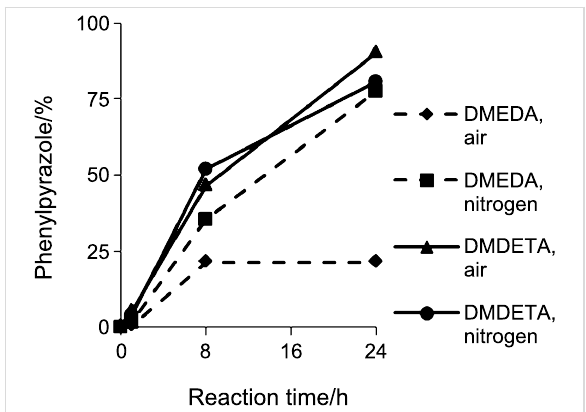
Figure 3: DMEDA versus DMDETA under air and nitrogen atmos- phere.